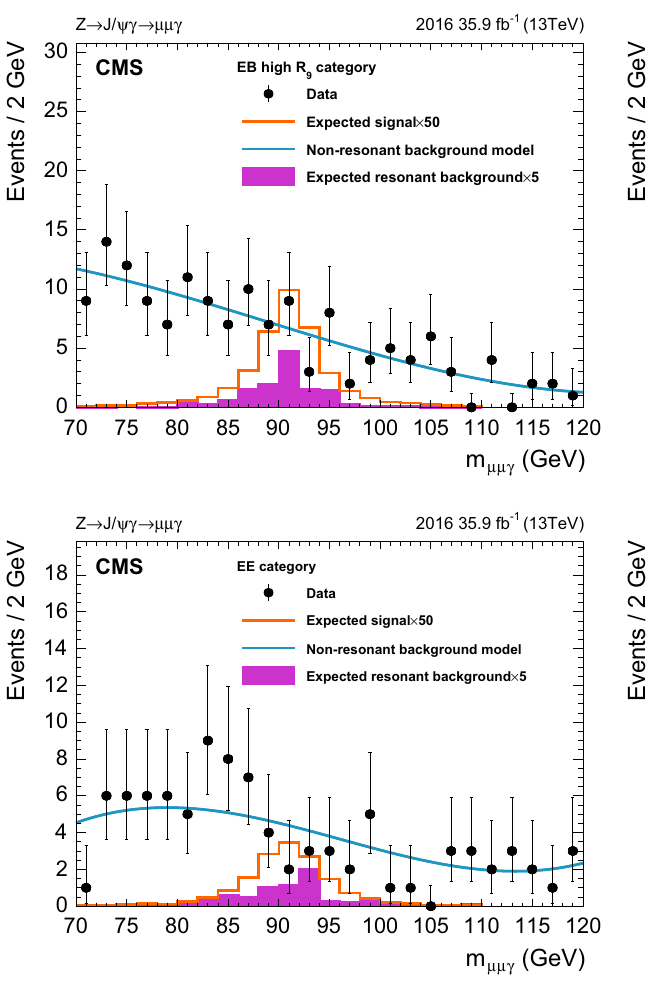
(top left), the EB low R 9 category (top right), the EE category (bottom left), as well as the H → J /ψγ channel (bottom right)